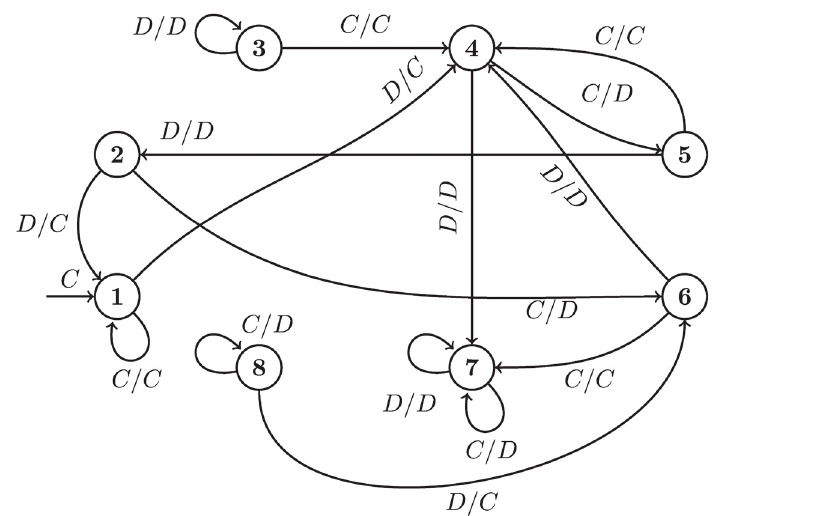
Fig 4. TF3: An 8 state finite state